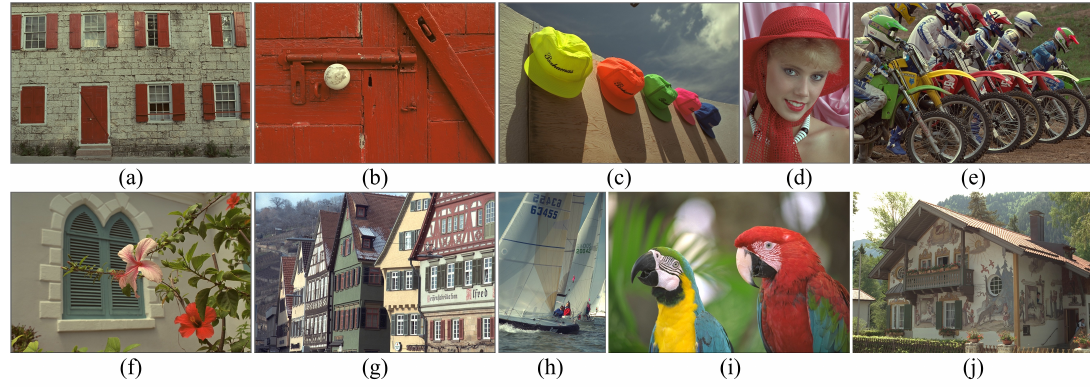
Figure 13. A set of test images used in the objective assessments of low-light image enhancement [29]: ( a – j ) are the test images of size 768 × 512 and the low-light image is synthesized by adjusting the non-linear gamma